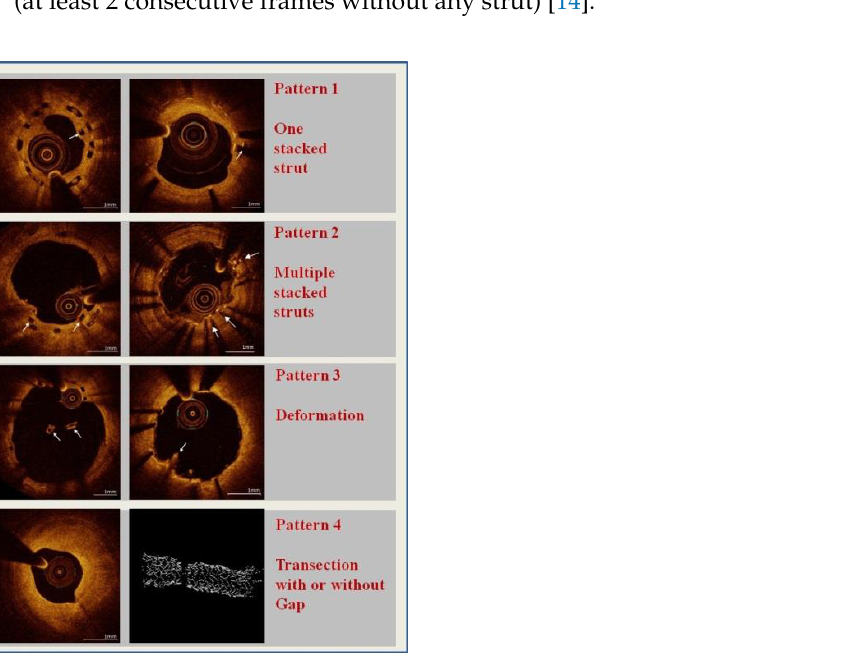
Figure 1. The different patterns of strut fracture (SF) in 2D and (in the case of pattern 4) 3D optical coherence tomography (OCT)